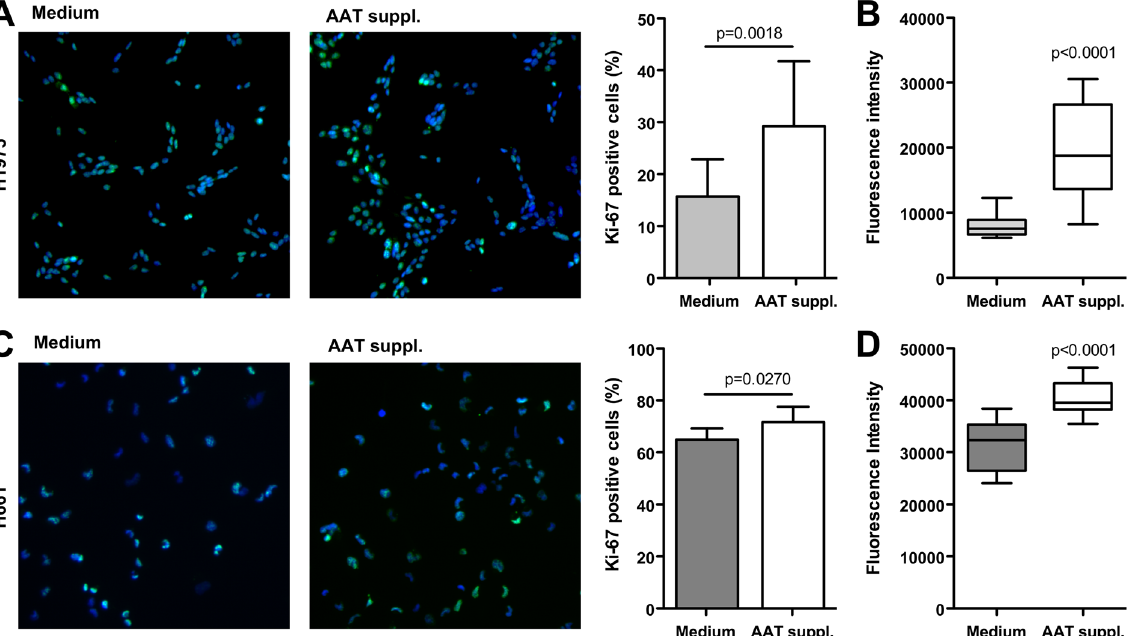
Figure 1. H1975 and H661 cells cultured in complete medium supplemented with 2 mg/ml AAT for 3 weeks show increased proliferation as compared to cells cultured in regular medium. All experimental data were generated from two independent cell cultures of H1975 and H661 cells cultured twice in complete medium without or with supplementation with AAT for 3 weeks. ( A ) (H1975) and C (H661) cells stained with the proliferation marker Ki-67 ( green ) and DAPI ( blue ). Graphs show percentages of Ki-67 positive cells (counted in six fields of three specimens from three independent experiments). ( B ) (H1975) and D (H661) cell proliferation determined with CyQUANT NF assay. Box plots show mean (standard deviation, SD) from three independent experiments carried out in quadruplicates (B) and from two independent experiments carried out with six repeats (D). p < 0.05 was considered as